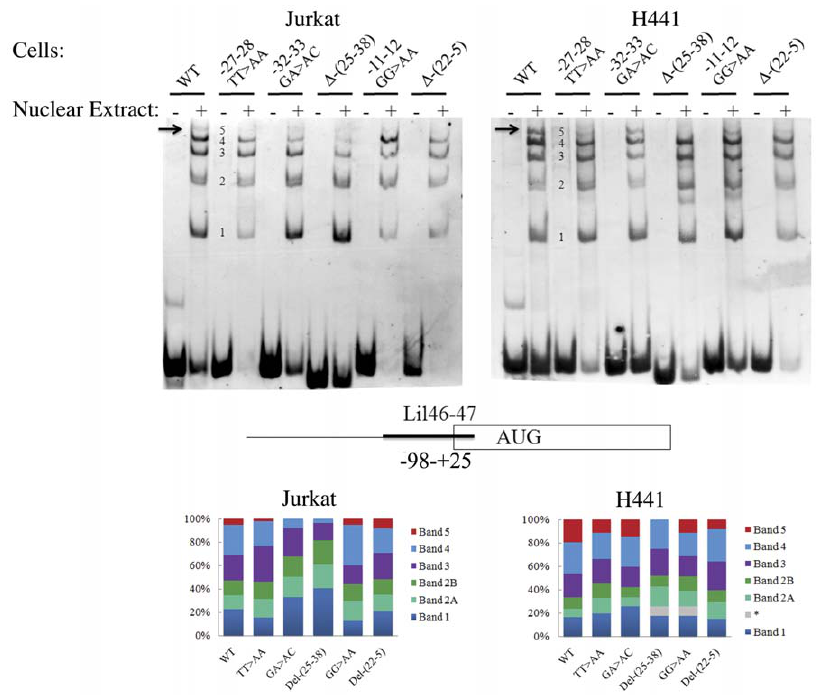
Figure 3. Mutations at various transcription factors binding sites affect protein complexes formation at the vav1 promoter. Electrophoretic mobility shift assay (EMSA) with Jurkat and H441 nuclear extracts was performed in the presence of lil46-47 digoxigenin-labeled probe (nucleotides 2 98 to + 28 of vav1 promoter). To produce the mutant oligonucleotides, the corresponding mutated plasmids (shown in Fig. 2B schematic) were used as template for the PCR. A schematic of vav 1 5 9 regulatory sequences, exon 1 and relative oligonucleotide position is shown at the bottom. Bound protein complexes are numbered 1 to 5. The arrow shows the position of complex 5, the heaviest complex that is sensitive to the mutations introduced into the oligonucleotide sequence. The bottom panels of the figure schematically show the relative intensity of bands 1–5 of the EMSA experiment as determined by densitometry (ImageJ software).